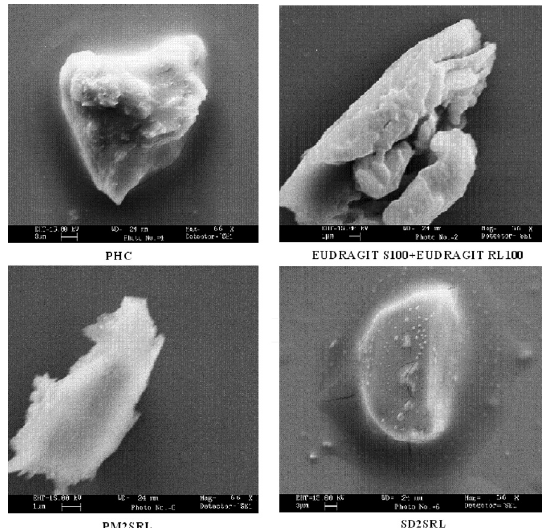
FIGURE 8 - 1 H-NMR Spectra of Pure drug, polymers, PM2SRL and SD2SRL. Figure 9. PHC and Eudragit polymers have quite different morphological characteristics. PHC appeared as irregular and three-dimensional crystals with smooth surfaces and homogeneous size. The combination of Eudragit S100 + RL100 (0.5 + 1.0), SEM analysis revealed the presence of rhomboidal shape crystals with different dimensions.